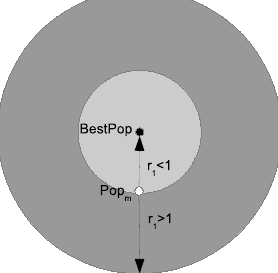
Figure 1. Searching spaces of SCA depending on r 1 .